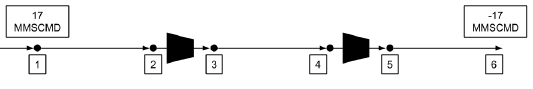
Figure 16. Example 1 gas network consisting of three pipes and two compressor stations. P L i